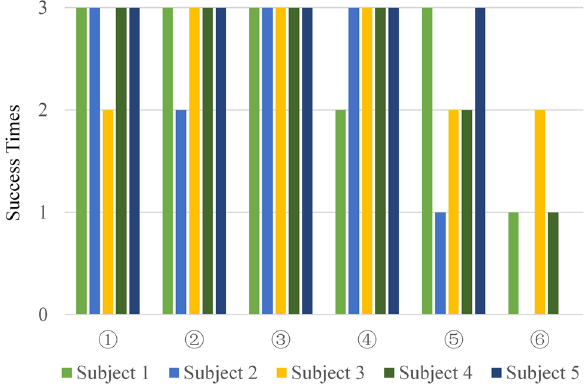
Figure 16. Task success results under the two control conditions.